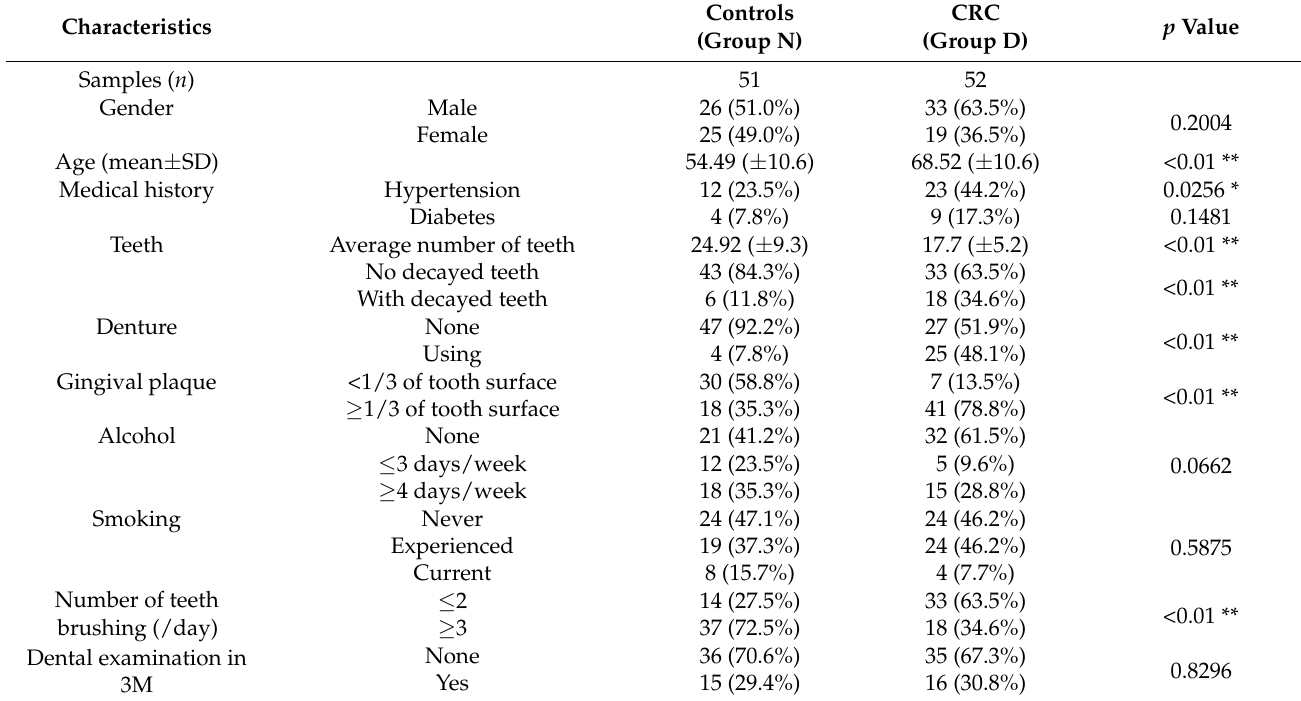
Table 1. Clinical characteristics of subjects in each group.